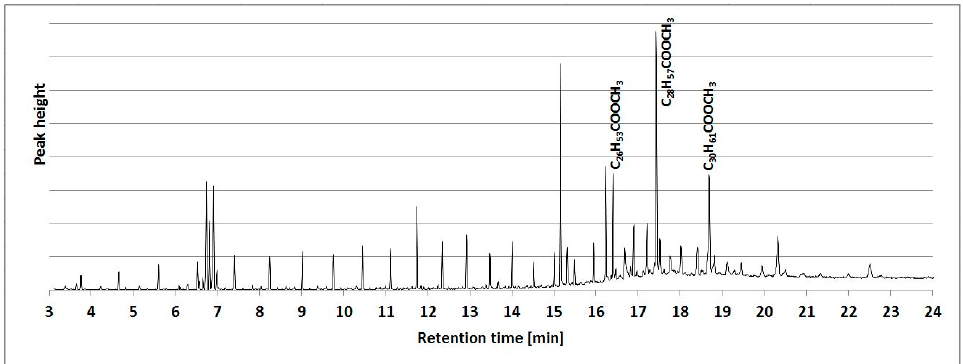
Figure 5. GC-MS chromatogram of product obtained by C30+ olefin oxidation using H 2 O 2 and O 2 (Table 8, Entry 1b; mass spectra Figures S9–S12).